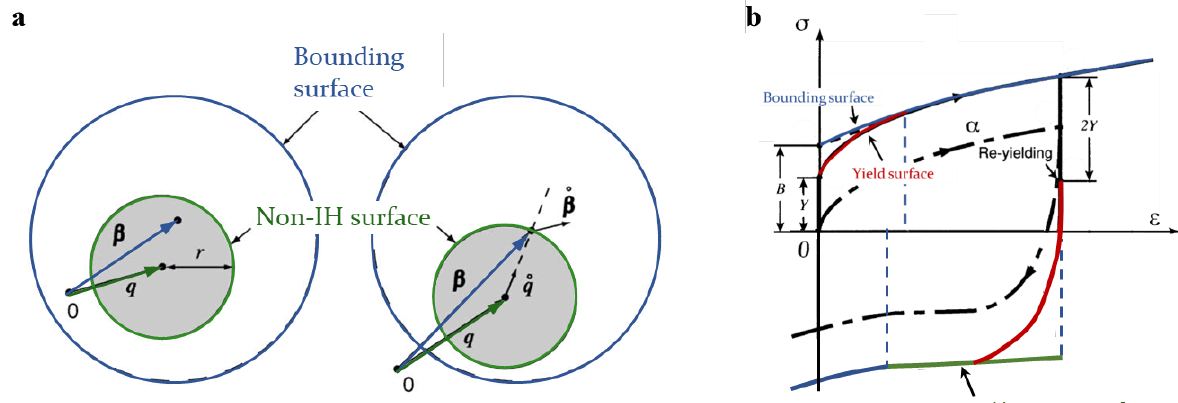
Figure 9. Schematic of the YU 02 model’s description of reverse hardening saturation: ( a ) the yield surface and ( b ) the stress–strain curve. Reprinted with permission from Ref. [61]. 2002, Yoshida, F. et al.